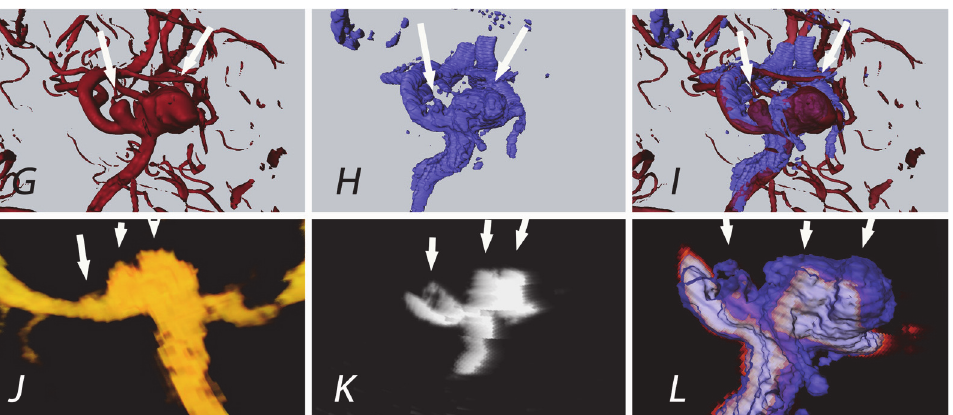
Fig 4. Patient 30: The white arrows indicate the aneurysms of the medial cerebral artery bifurcation. Contrary to rDSA (G; 2 aneurysms detected), 3 aneurysms were displayed in 3D-ioUS (H, J, K; 2 on MCA bifurcation and the 3rd aneurysm on M2 branch) as confirmed by the intraoperative view; (rDSA (red), 3D-ioUS (blue, glow- orange)); G: pre-clipping rDSA; H: pre-clipping 3D-ioUS; I: coregistration of G+H; J: MIP 3D-ioUS; K: MIP of 3D-ioUS; L: coregistration of K+H.